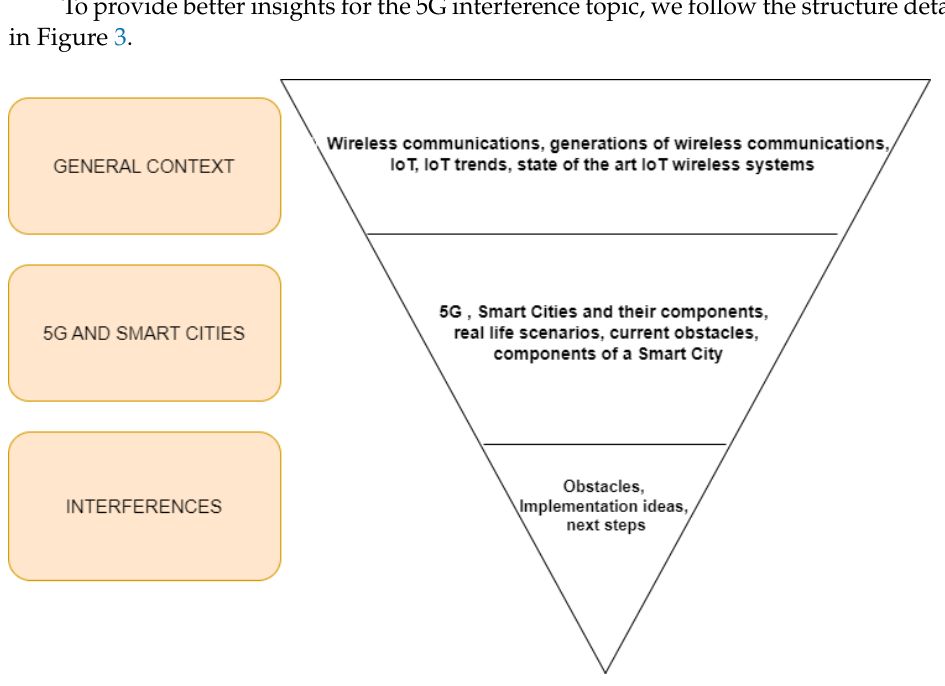
Figure 3. 5G and IoT technologies’ impact